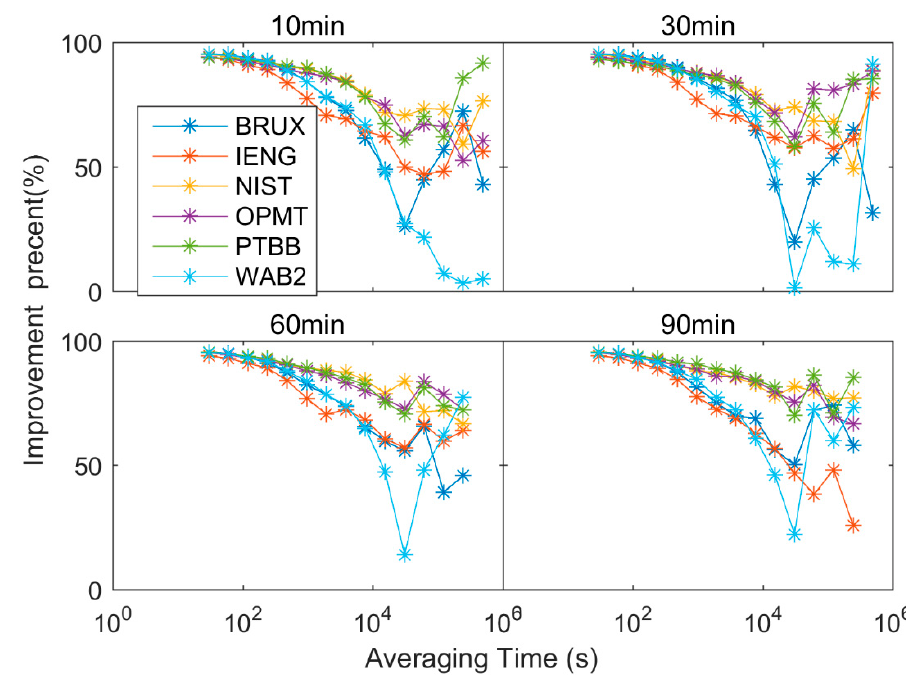
Figure 9. Improvement of the frequency stability (percent) of scheme 2 compared to scheme 1.